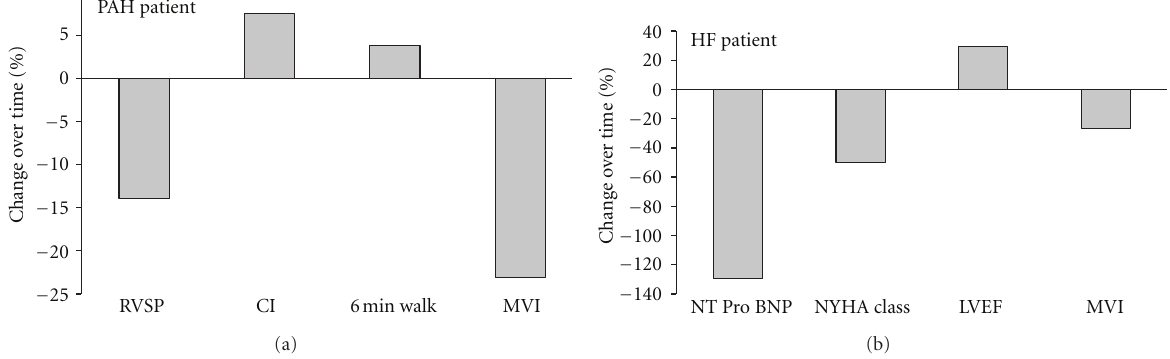
Figure 6: Tracking disease status over time, (a) PAH patient 3 mo. after treatment demonstrating modest improvements in clinical measures and the MVI score, (b) HF patients 3 mo. after CRT device implantation demonstrating similar directional changes in MVI score with clinical metrics.